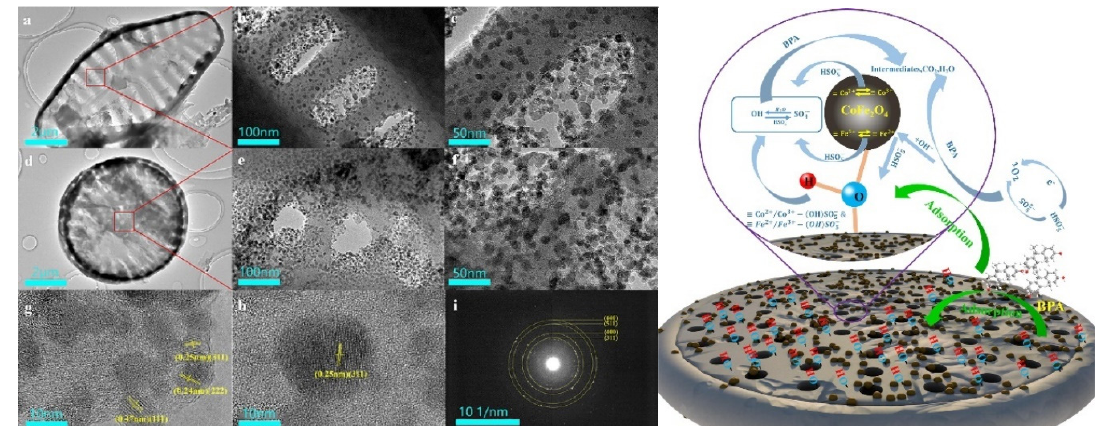
Figure 3. Images of ( left ) TEM micrographs of diatomite particles on to which CoFe 2 O 4 nanoparticles were placed and ( right ) a proposed mechanism scheme for the conversion of PMS into reactive oxygen species for the degradation of bisphenol A. Reprinted from Zhang et al. [85] with permission from Elsevier.